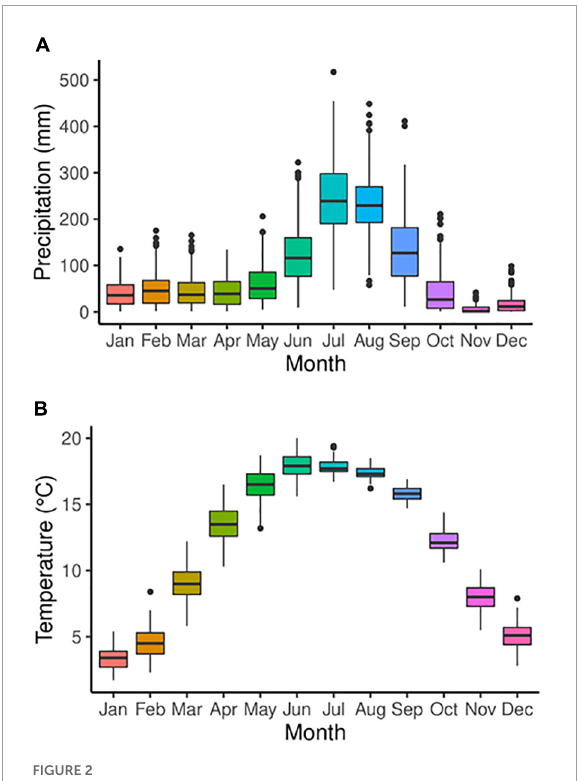
FIGURE2 Boxplot showing monthly mean climate data for the region. (A) Monthly mean precipitation; (B) monthly mean temperature over the period